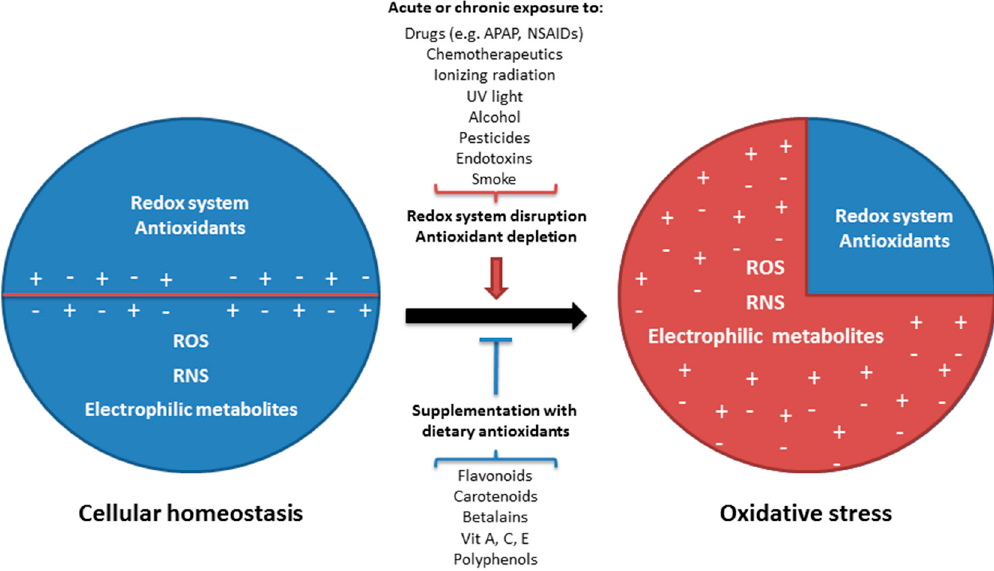
Figure 2. Disruption of the redox system leads to oxidative stress and cellular injury. ROS, reactive oxygen species; RNS, reactive nitrogen species; APAP, acetaminophen; NSAIDs, non-steroidal anti-inflammatory drugs.